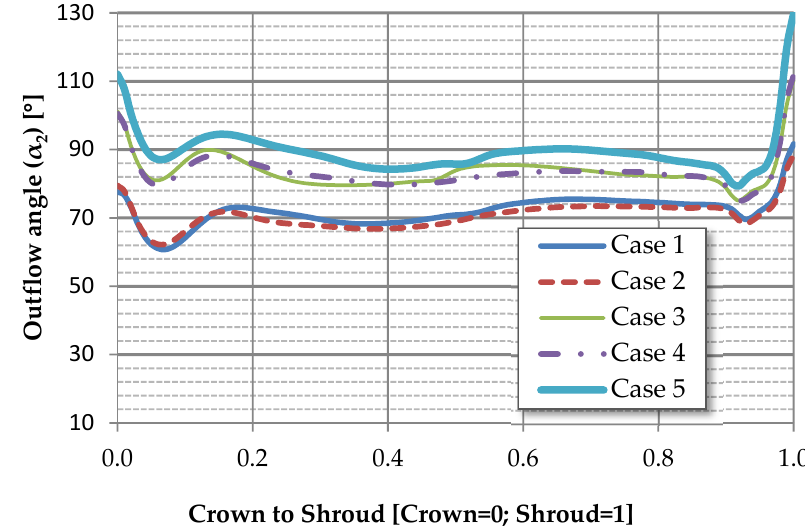
Figure 11. Outflow angle distribution.